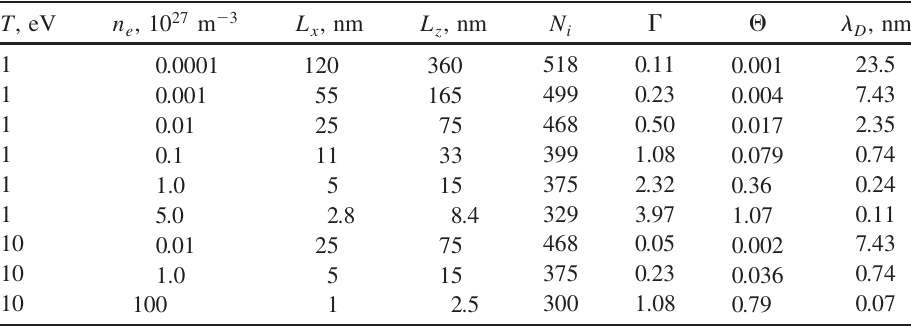
TABLE I. MD simulation parameters: T is the initial electron temperature, n e is the initial number density of electrons (or ions), L z is the transversal simulation box size, L x is the longitudinal simulation box size, N i is the number of ions which is equal to the initial